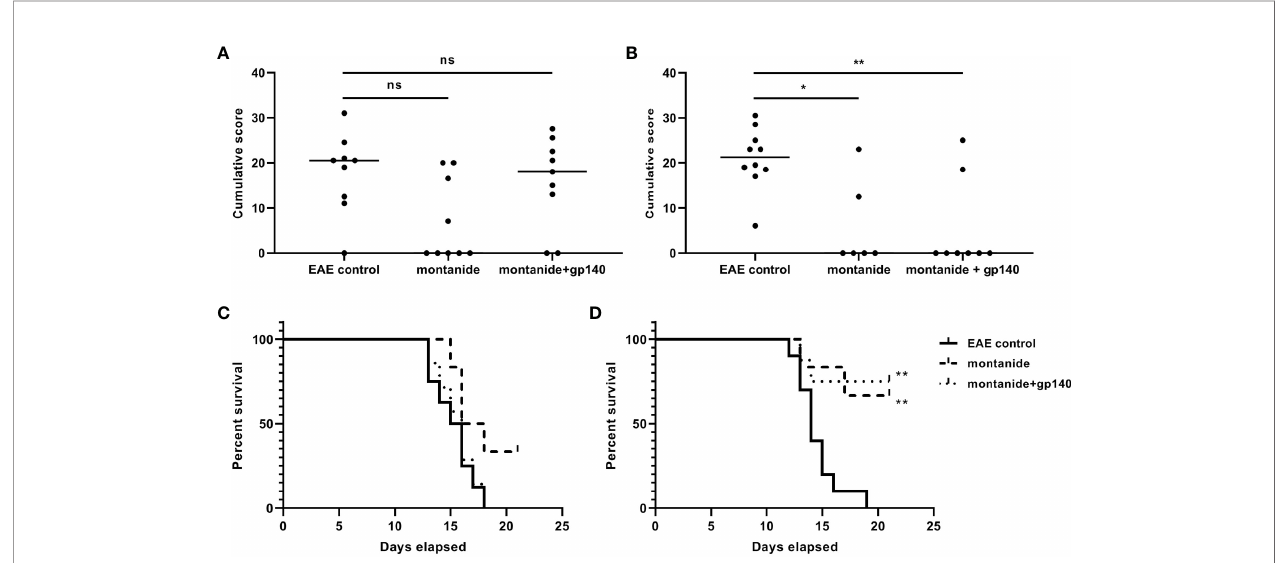
FIGURE 6 | Clinical evaluation of EAE. Score of the disease in 28-weeks (A) and 7-weeks old C57B/6 mice (B) . The data are plotted as the mean daily clinical score for all animals in a particular treatment group. Kaplan – Meier analysis showing the statistically signi fi cant differences in the median time of EAE onset in 28- weeks (C) and 7-weeks old C57B/6 mice (D) . Signi fi cance is expressed as follows: *p < 0.05, **p < 0.01, ns, not signi fi